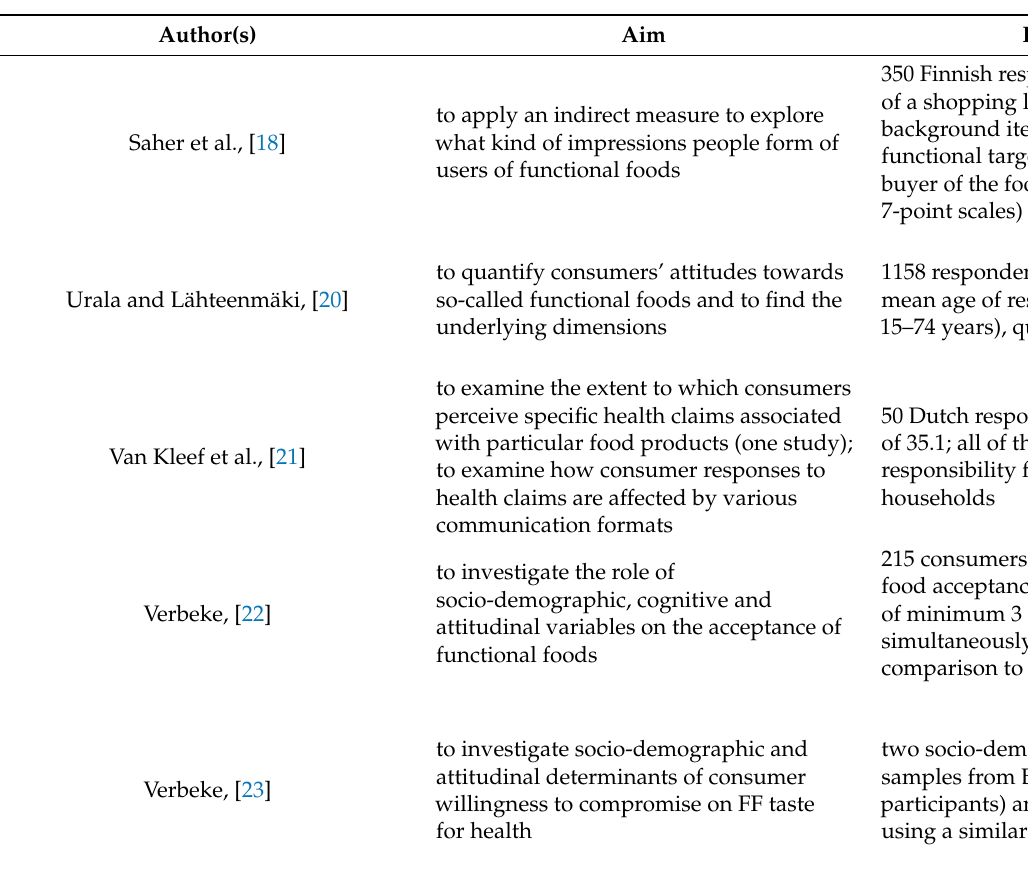
Table 2. Factors influencing consumer attitudes toward functional